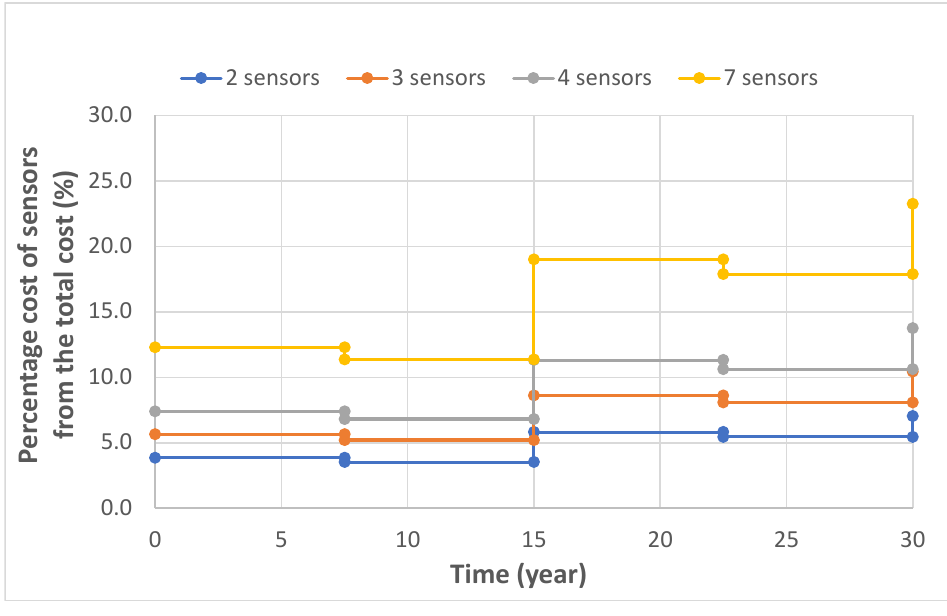
Figure 15. Percentage cost of sensors from the total cost.